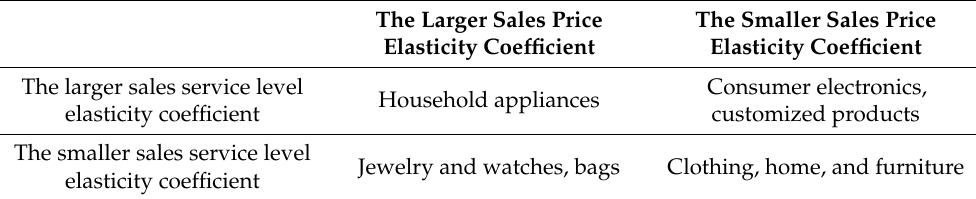
Table 3. Products classification based on elasticity